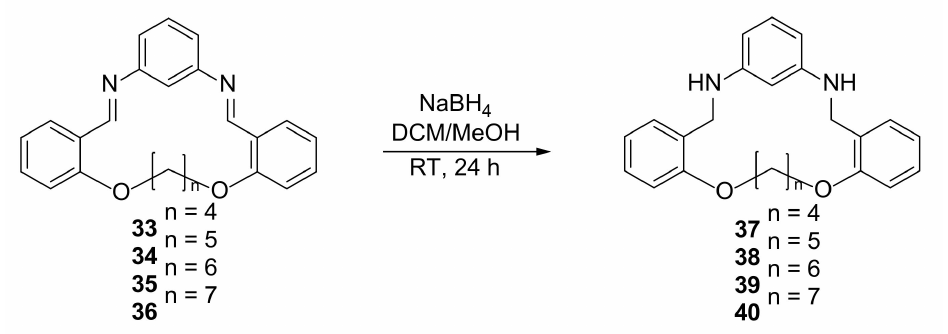
Figure 6. Synthesis of the series of N 2 O 2 -donor macrocycles 37 – 40 .